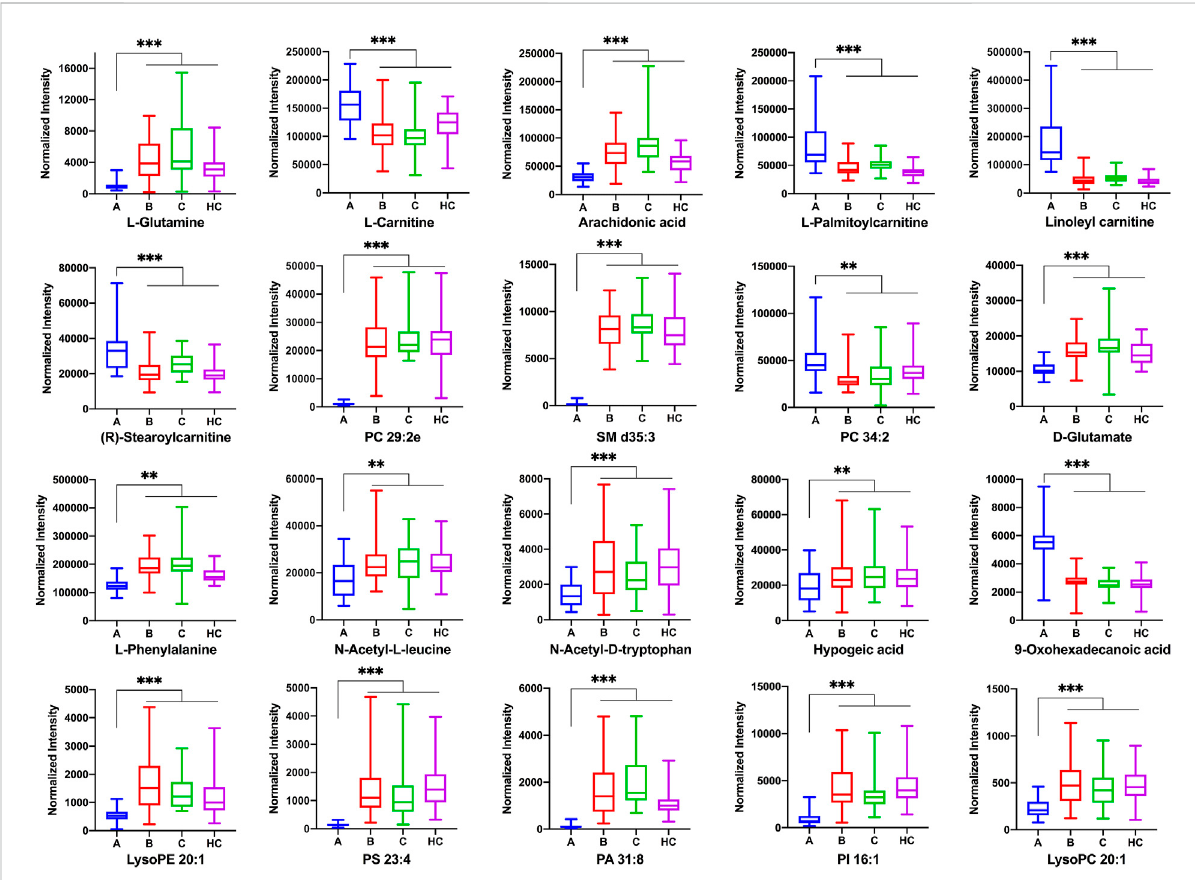
FIGURE 4 The normalized peak intensity of 20 representative differential metabolites among A, B, C, and HC groups. p ** < 0.01; p *** < 0.001.